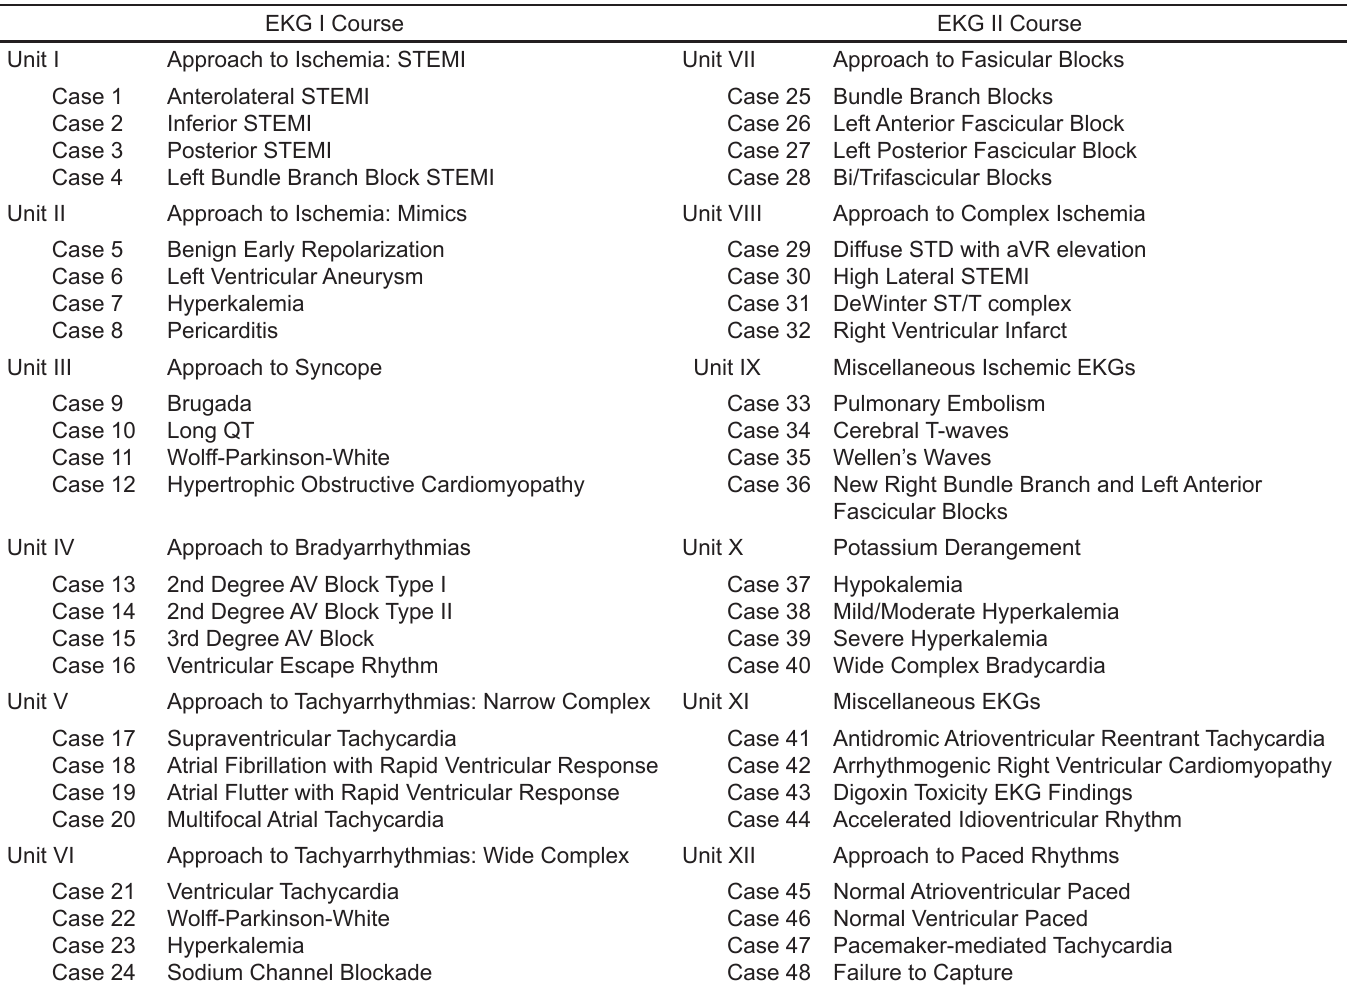
Table 1. EKG I and EKG II